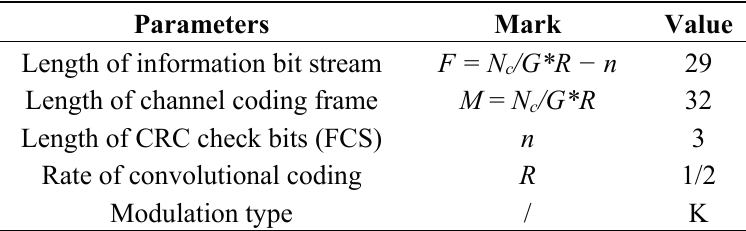
Table 2. The simulation parameters of time-frequency